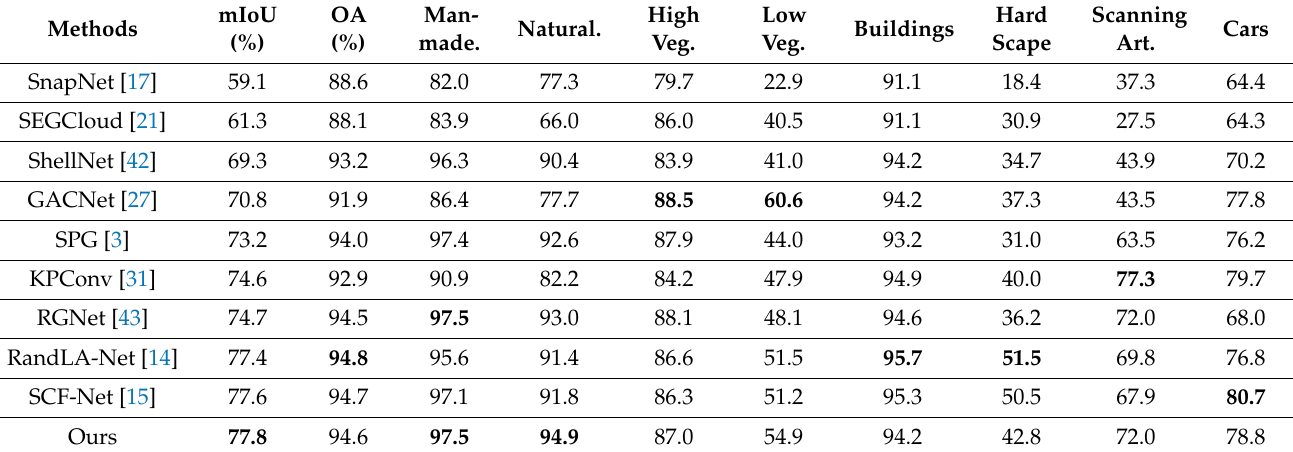
Figure 8. The visualization results of some rooms. (The first line: conference; the second line: hallway, the other lines: office). Table 2. The semantic segmentation results of Semantic3D (reduced −